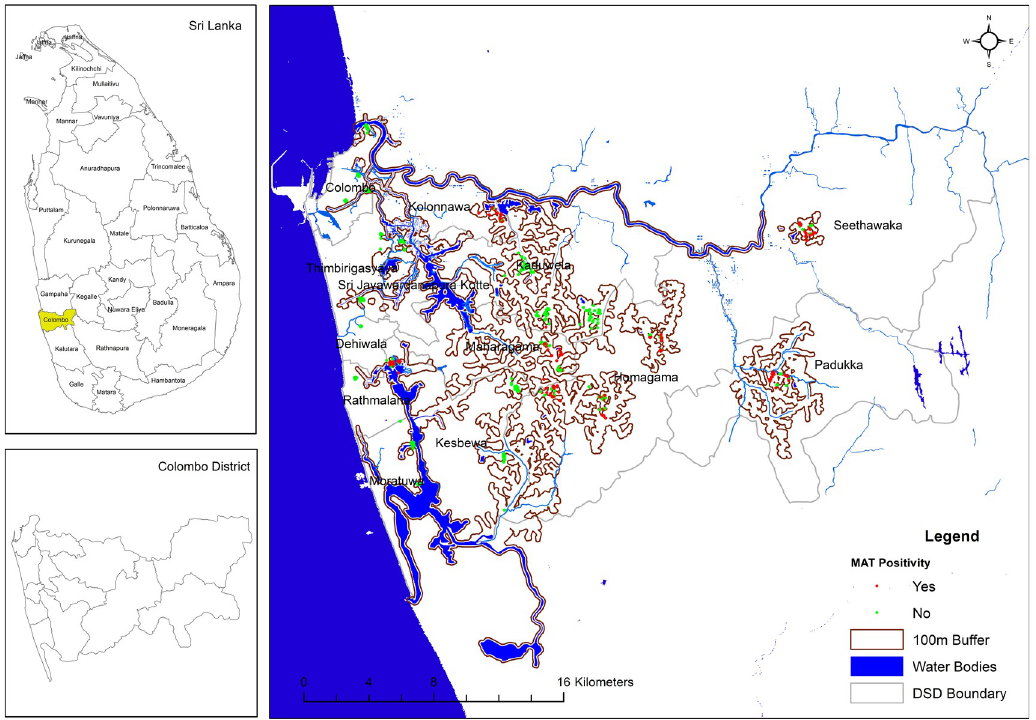
Fig 3. MAT positivity and distribution among water bodies. This image is licensed under the Creative Commons Attribution 4.0 International License (http://creativecommons.org/licenses/by/4.0/).